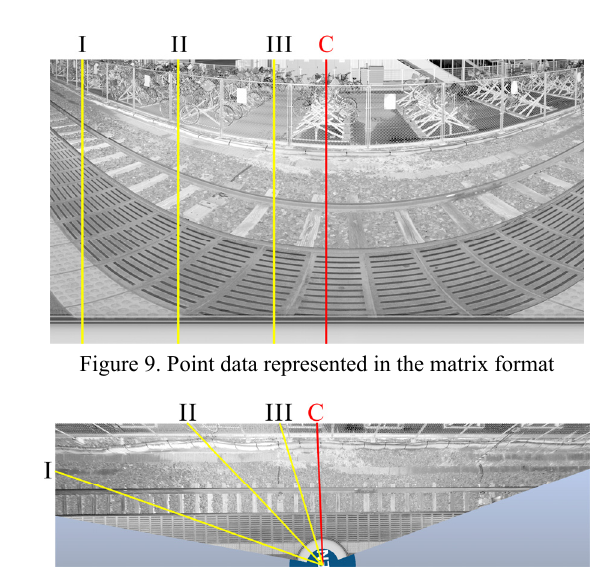
Figure 10. Point data represented on the plan